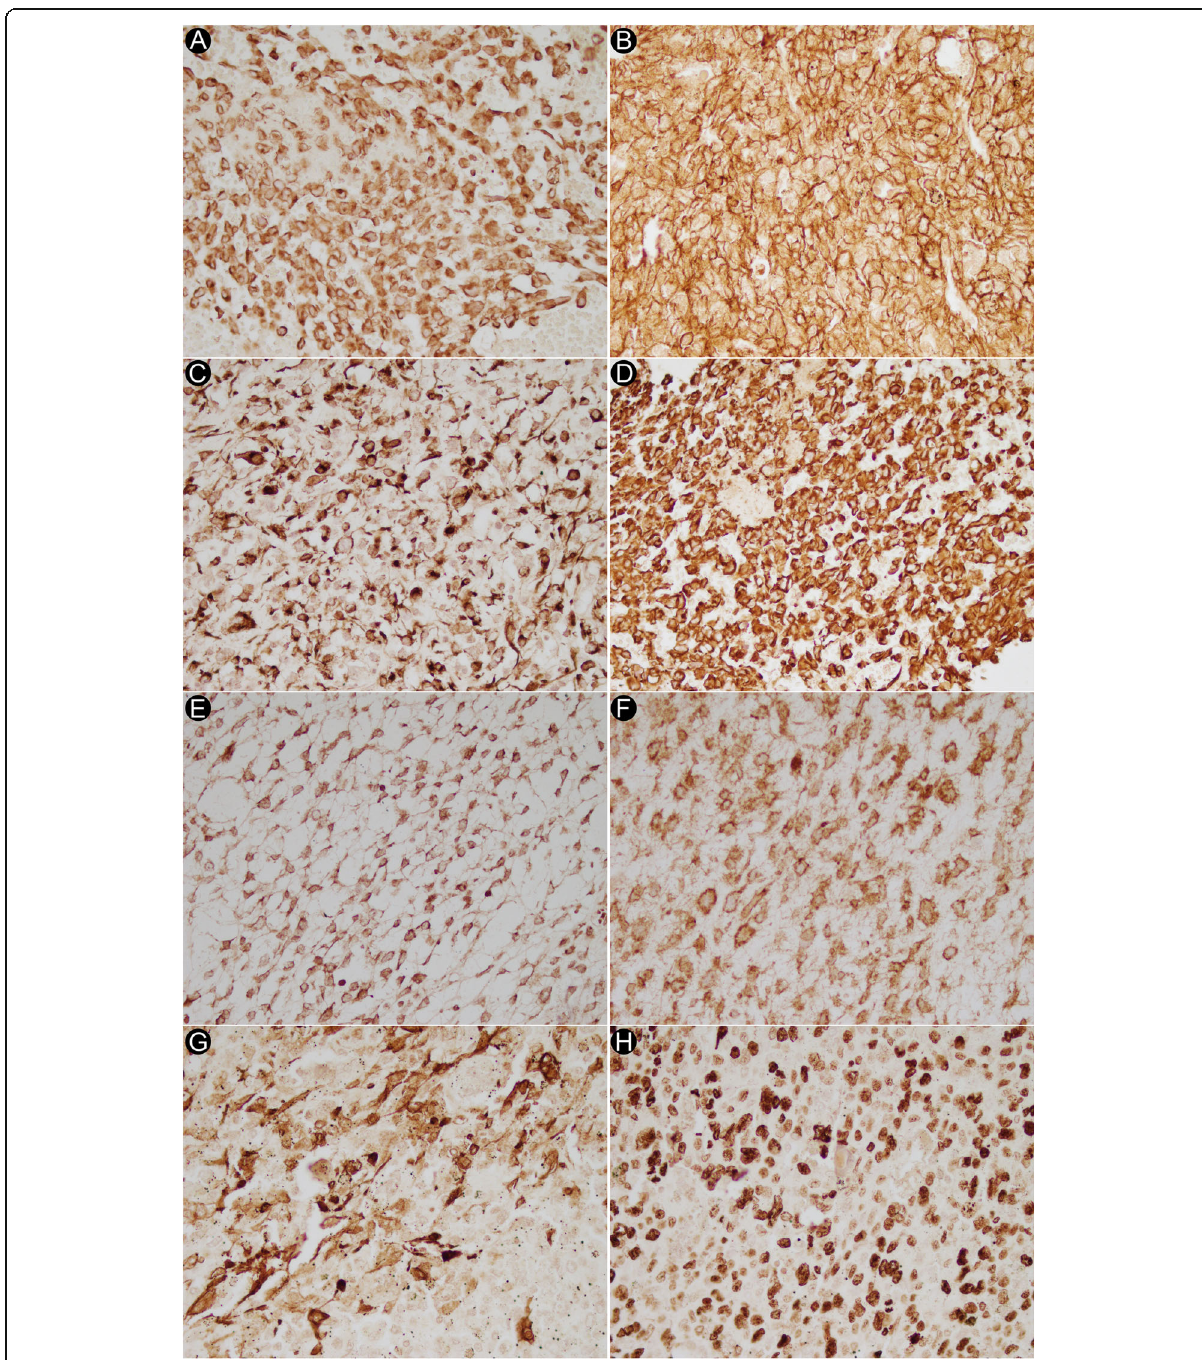
Fig. 4 Immunohistochemical findings in UESL. ( A ) Glypican 3 ( B ) CD56 ( C ) Desmin ( D ) Vimentin ( E ) BCL2 ( F ) CD10 ( G ) SMA ( H ) Ki67